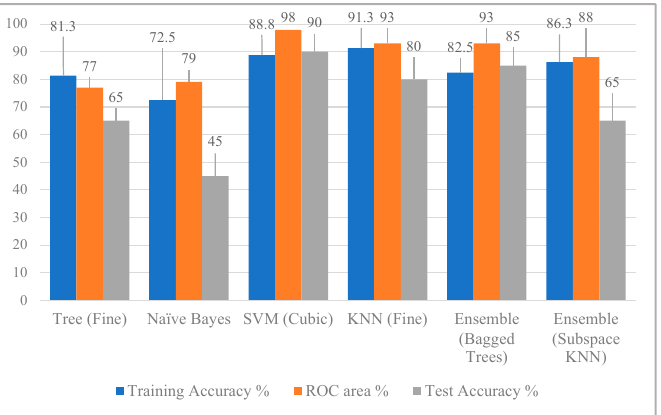
Figure 12. Performance of different classifiers using the automatically extracted features.